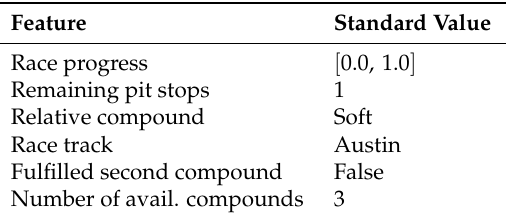
Table 16. Standard values used to create the race for the feature impact analysis of the compound decision